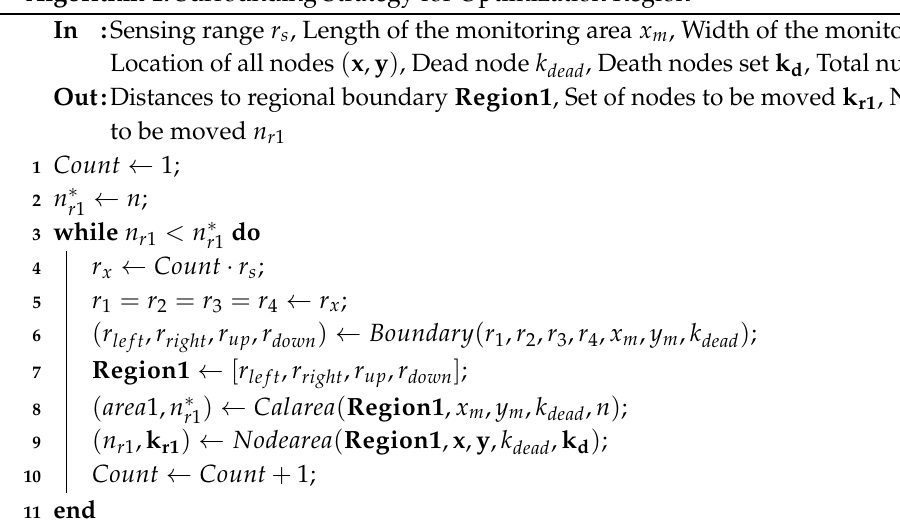
Algorithm 1: Surrounding Strategy for Optimization